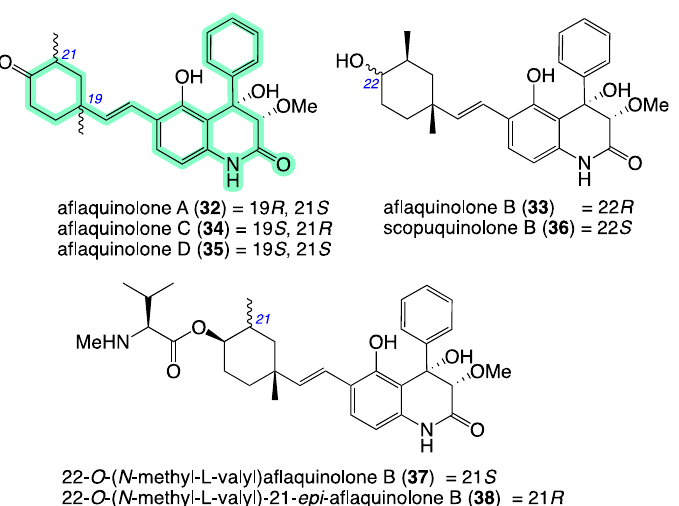
Figure 9. Structures for known aflaquinolones and analogues 32 – 38 . Highlighted: carbo/heterocyclic scaffold (green). Table 4. 1D NMR (methanol- d 4 ) data for aspulvinone Y ( 14